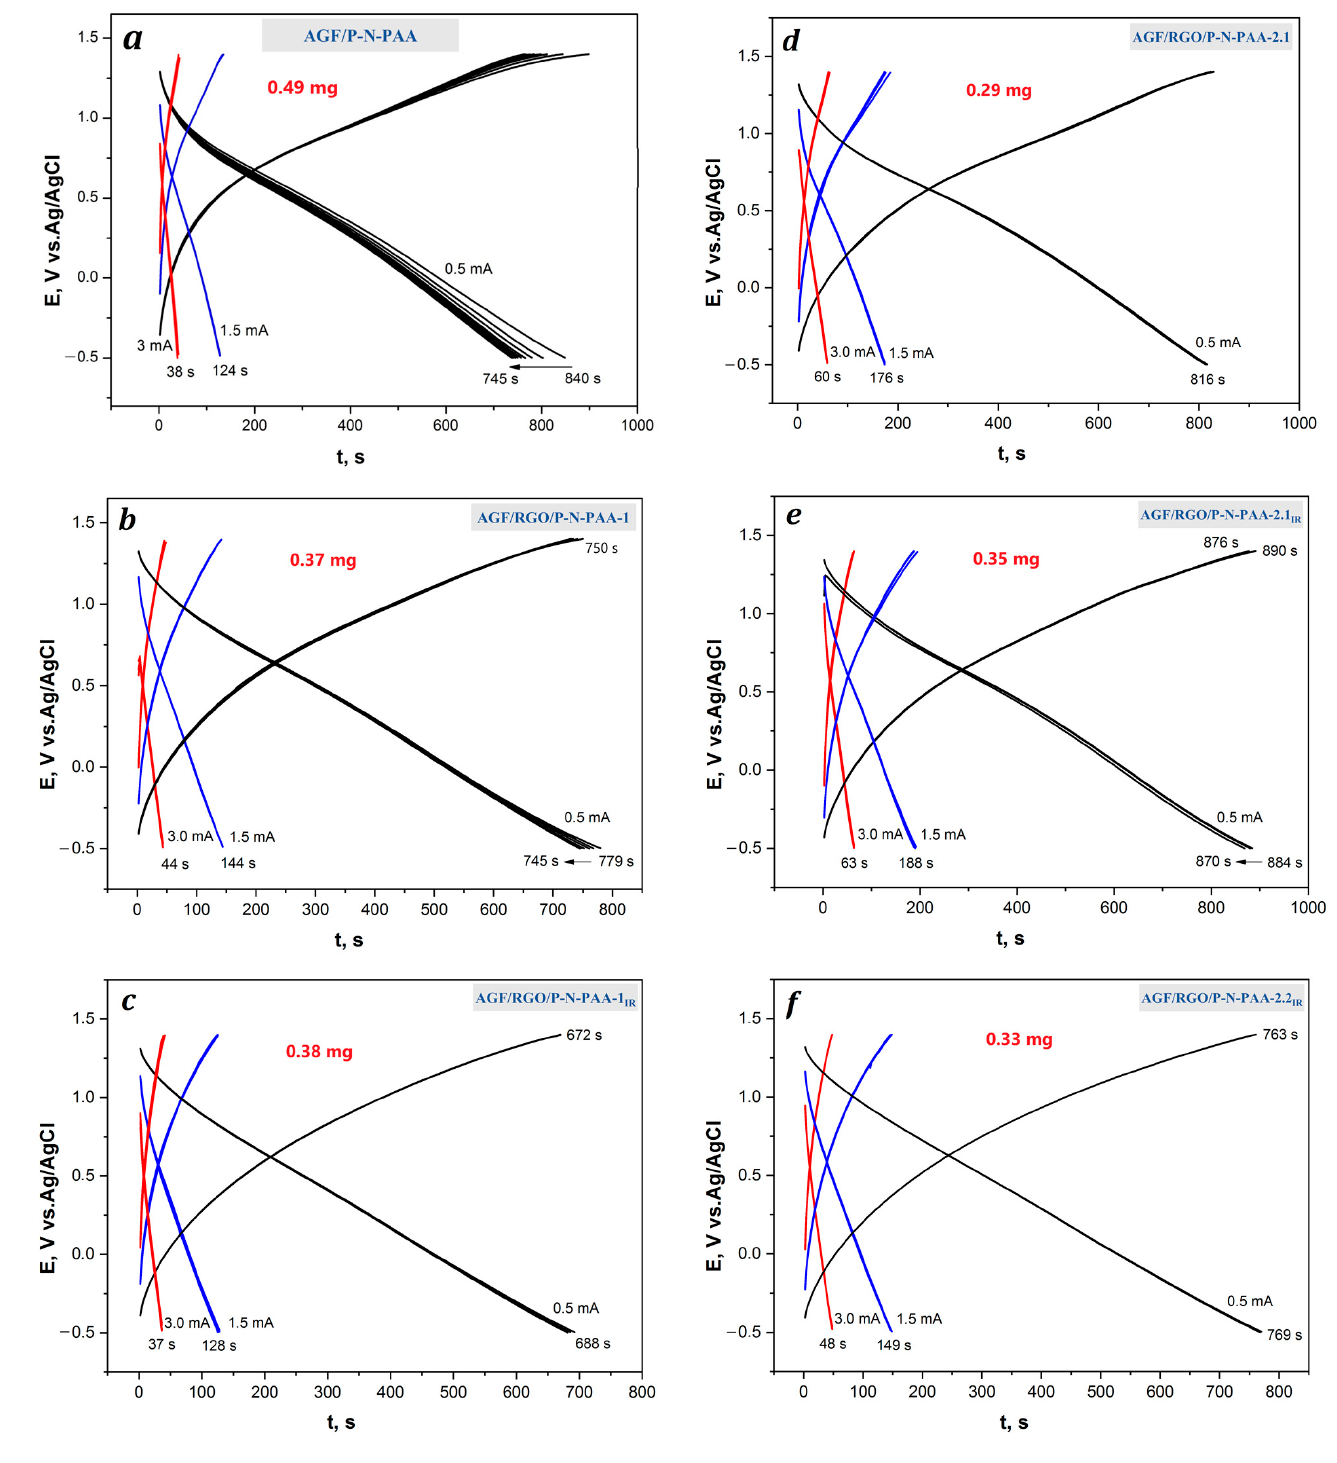
Figure 12. Galvanostatic charge–discharge dependencies of the AGF/P-N-PAA ( a ) and AGF/RGO/P- N-PAA before ( b , d ) and after IR heating ( c , e , f ) at 0.5, 1.5 и 3.0 mA·cm –2 . Table 5. Electrochemical characteristics of AGF/RGO/P-N-PAA electrodes in 1 M LiClO 4 in propylene carbonate.